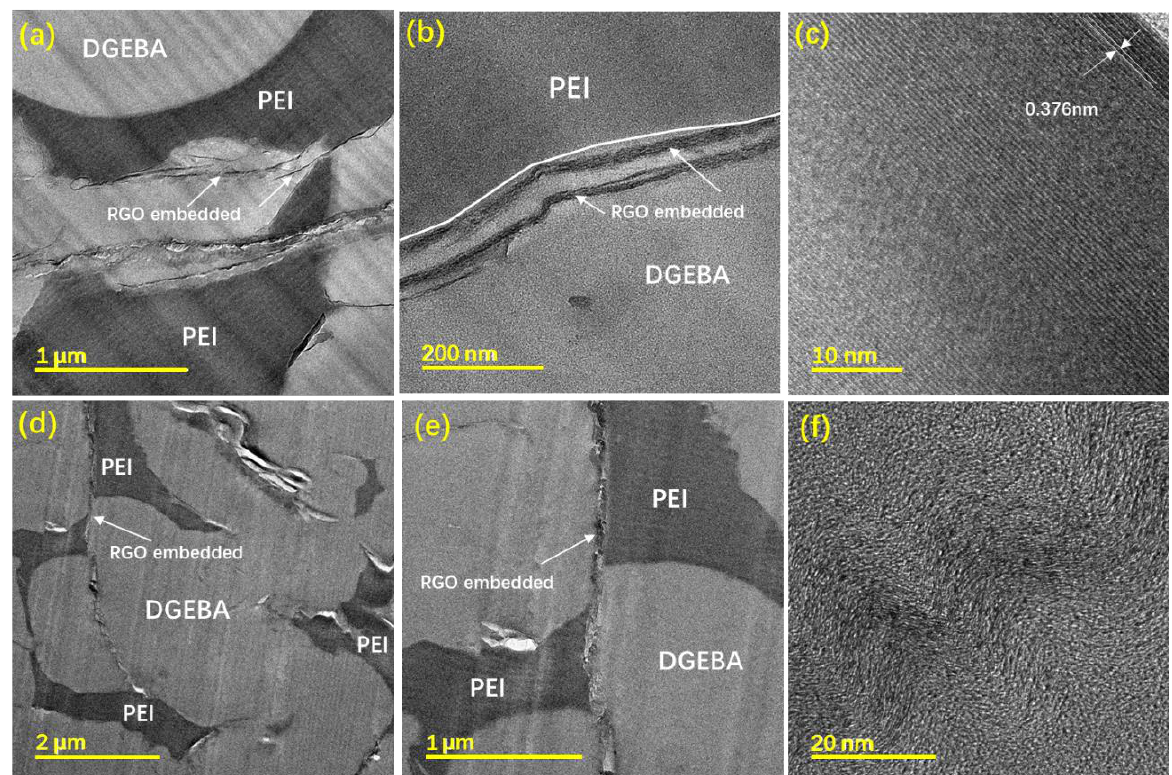
Figure 4. The FETEM micrographs of the DP25R3 nanocomposite at ( a ) lower and ( b ) higher magnification, ( c ) HRTEM micrograph of RGO in DP25R3, ( d , e ) DP30R3 nanocomposite with inversion morphology, and ( f ) HRTEM micrograph of RGO in DP30R3.